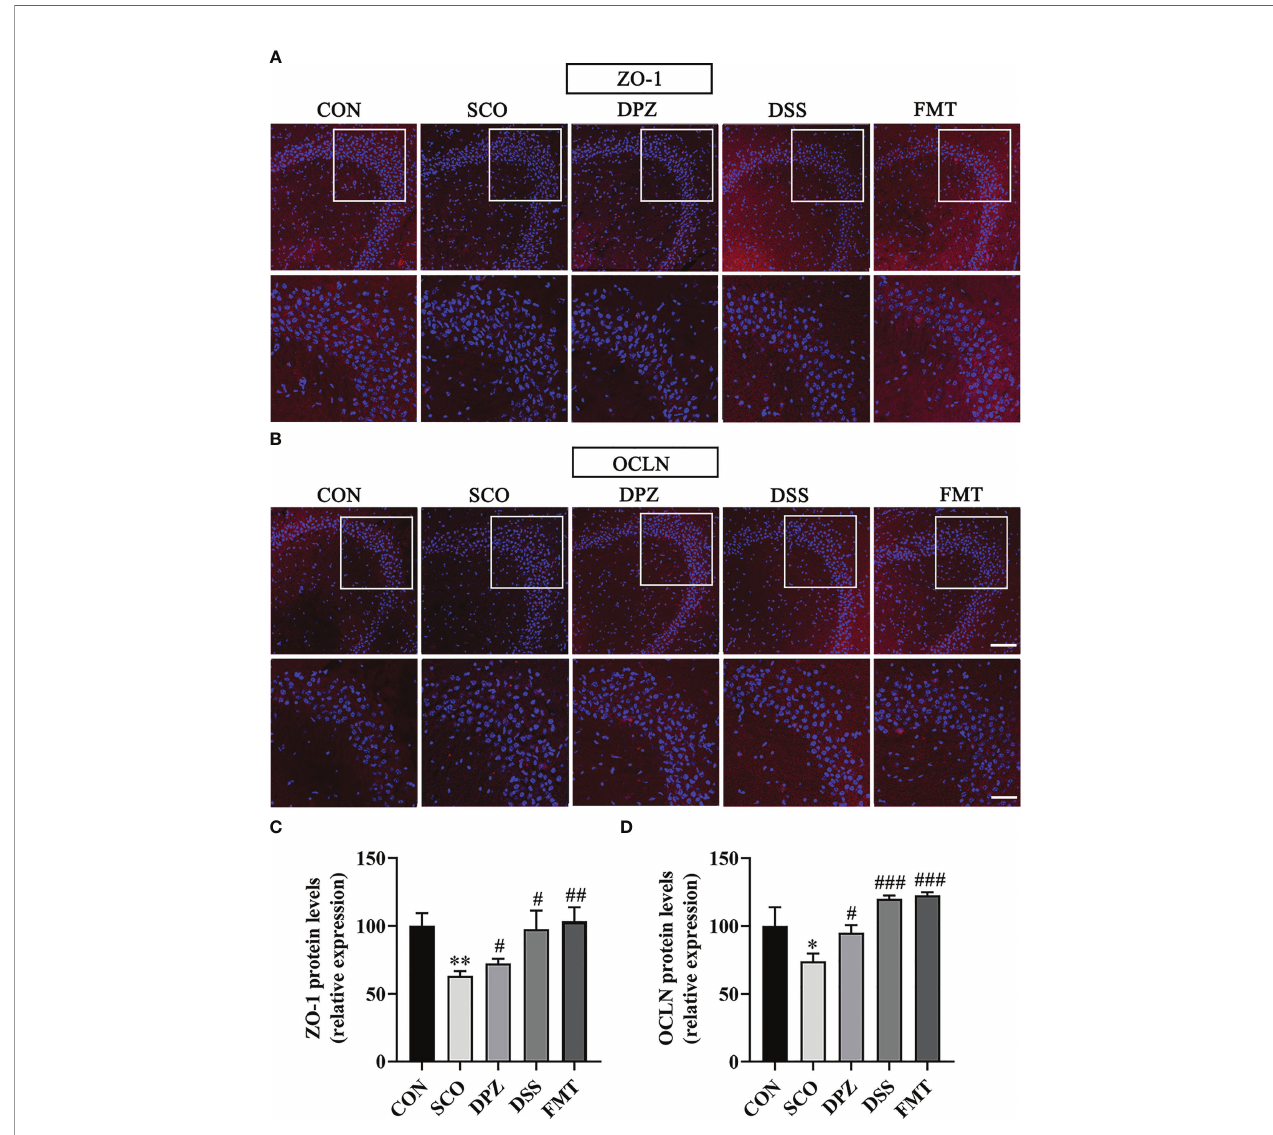
FIGURE 10 | The protective effects of (A, B) on the hippocampus. Immuno fl uorescence staining of ZO-1 (A) and OCLN (B) was observed under a fl uorescence microscope at ×20 magni fi cation (bar = 100 m m) and ×40 magni fi cation (bar = 50 m m). ZO-1 (C) and OCLN (D) were represented by fl uorescence quantitative statistics. (n = 3) * p < 0.05, ** p < 0.01, vs. CON, # p < 0.05, ## p < 0.01, ### p < 0.001 vs.